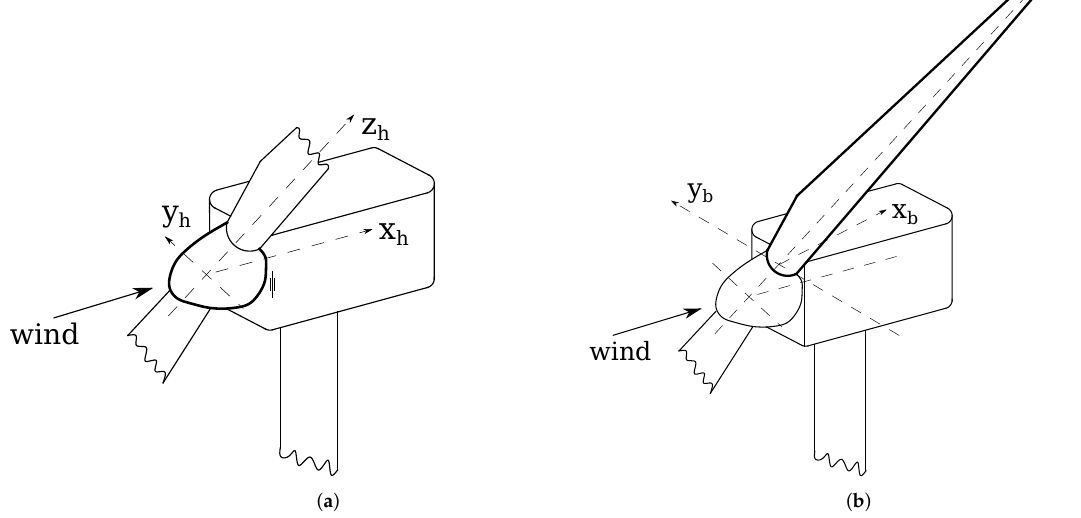
Figure 2. Schematic of the coordinate systems associated with ( a ): the rotor hub, and ( b ): the blade root, according to the International Electrotechnical Commission (IEC) standards